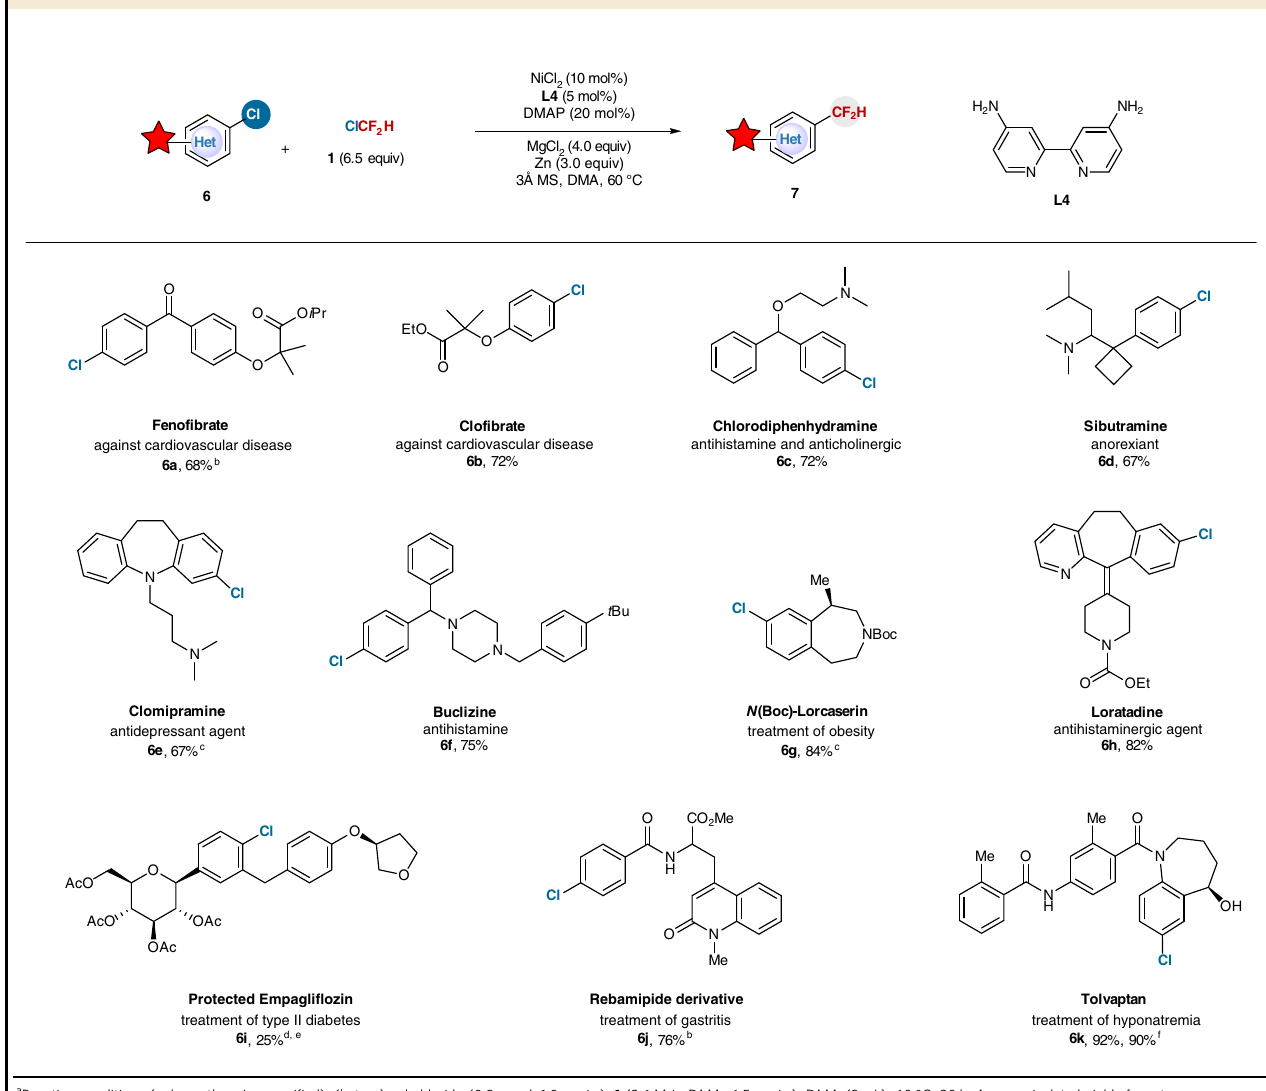
Table 3 Late-stage di fl uoromethylation of pharmaceuticals